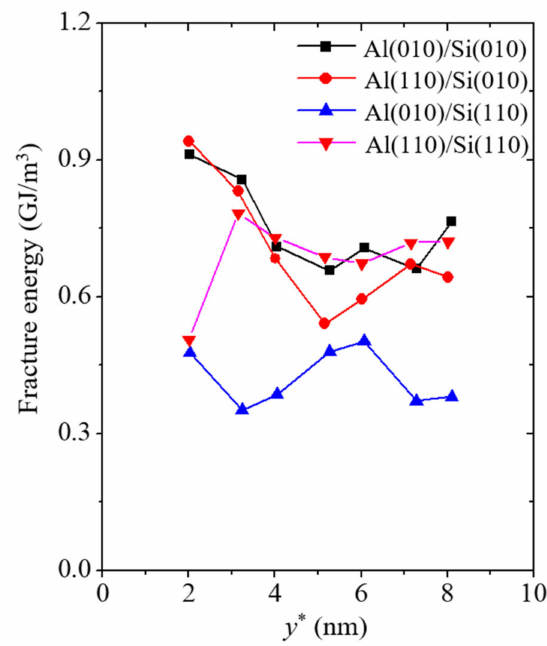
Figure 8. Fracture energy corresponding to the varying thicknesses of Al nanofilm denoted by the variable y